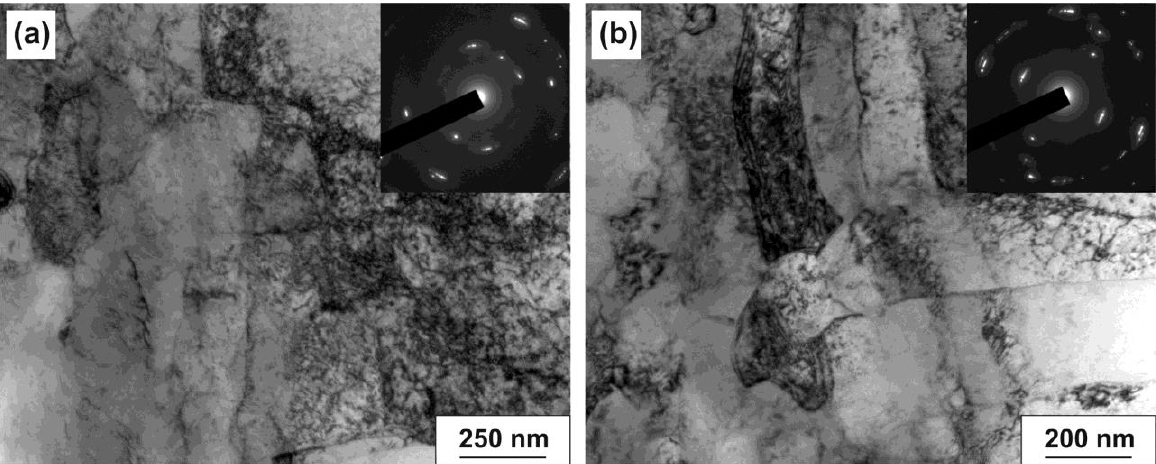
Figure 5. ( a , b ) Bright-field TEM images of the microstructure of the copper shell of the 2.5-mm diameter composite sample ( e = 4.16).